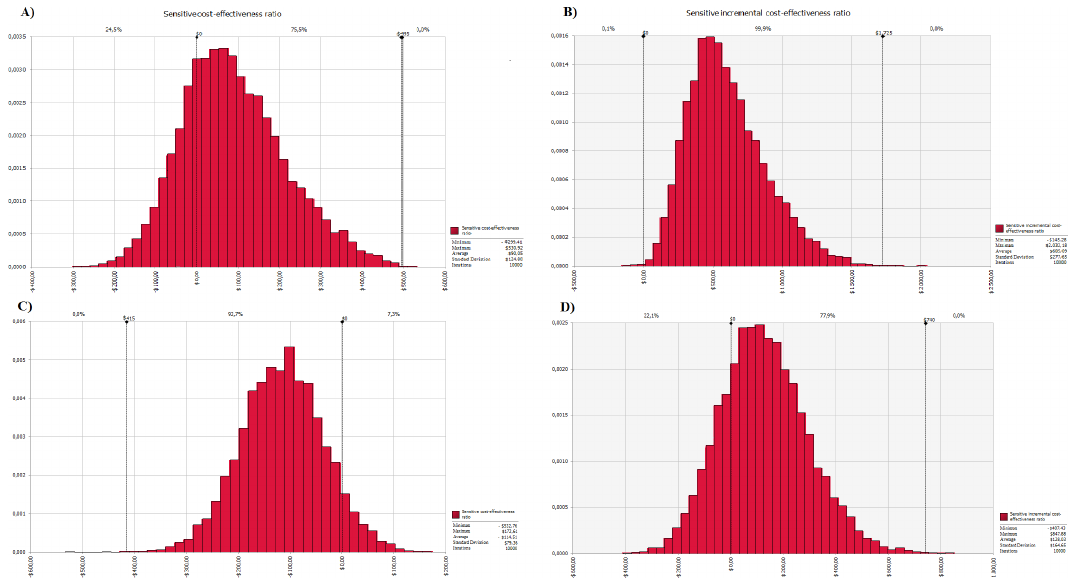
Fig 4. Monte Carlo simulation sensitivity analysis for the ratio of cost effectiveness and the ratio of incremental cost effectiveness in the period. Pre-PC period = baseline; A) Monte Carlo simulation sensitivity analysis for ratio of cost effectiveness of pharmaceutical care compared to baseline; B) Monte Carlo simulation sensitivity analysis for ratio of incremental cost effectiveness of pharmaceutical care compared to baseline; C) Sensitivity analysis by Monte Carlo simulation for ratio of cost effectiveness post pharmaceutical care compared to baseline; D) Sensitivity analysis by Monte Carlo simulation for ratio of incremental cost effectiveness for post pharmaceutical care compared to baseline. 10,000 iterations were performed in Monte Carlo simulation to evaluate the variation of the values of the ratio of cost effectiveness and the ratio of incremental cost effectiveness on the variation of costs by pertinent patient to the probability distribution of costs and pressure control percentage of outcome for each baseline year, for the year of pharmaceutical care, and each year after pharmaceutical care. It can be highlighted that after pharmaceutical care there is not the cost of pharmaceutical care for the calculation of the ratios, thus, the ratios reflect the conventional cost for the care of hypertensive patients’ health in the Public Health System as baseline, compared to the result of pharmaceutical care on conventional health costs. Monte Carlo simulations for CER were structured to represent the probability of CER in the PC and post-PC periods being greater than the baseline CER, thus part A) reflects the result of CER difference of the PC period minus the baseline CER period and part C) reflects the result of the difference of the post-PC CER period minus the baseline CER